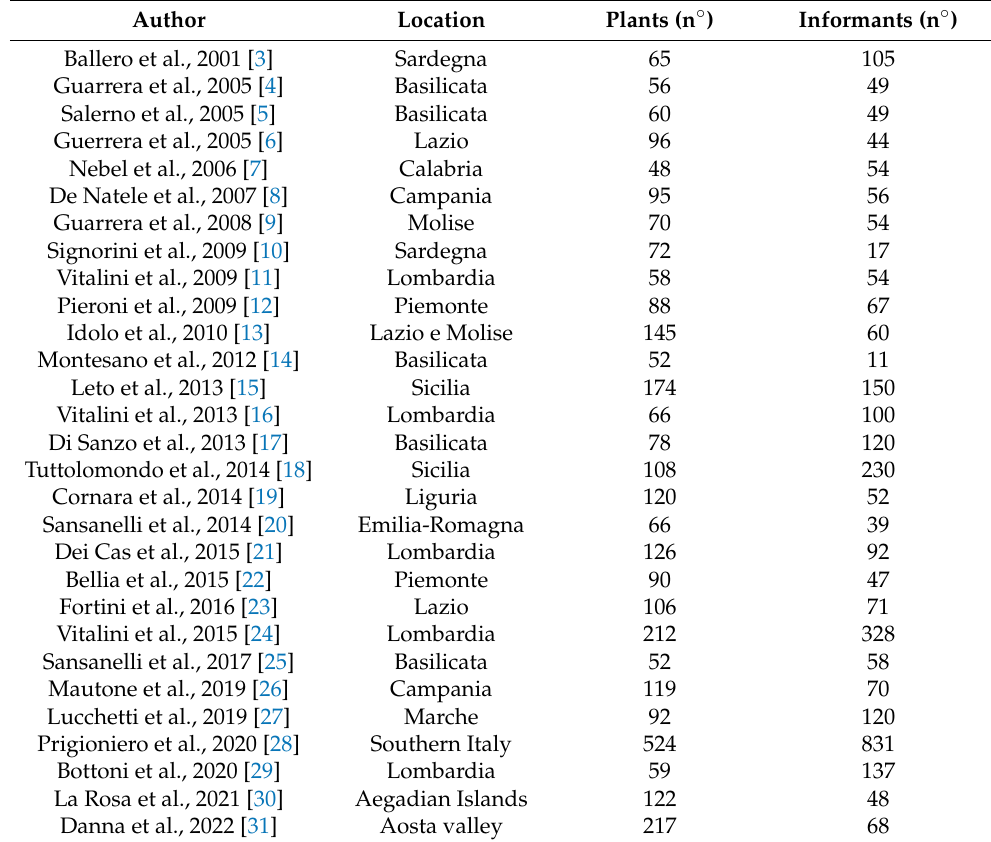
Table 1. Ethnobotanical investigations carried out in different Italian areas from 1981 to